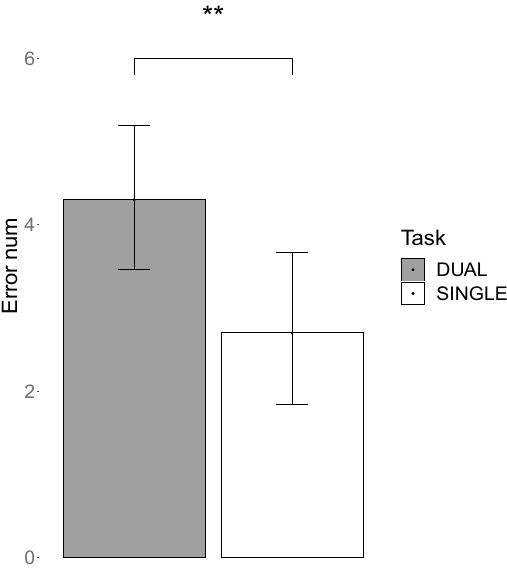
Figure 4. Mean number of errors as a function of task difficulty. ** p < 0.01.